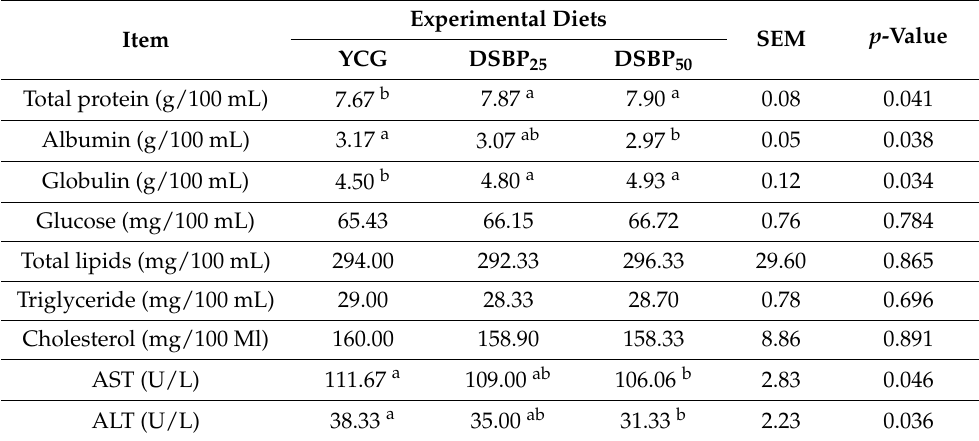
Table 7. Plasma biochemical parameters of cows fed experimental diets.